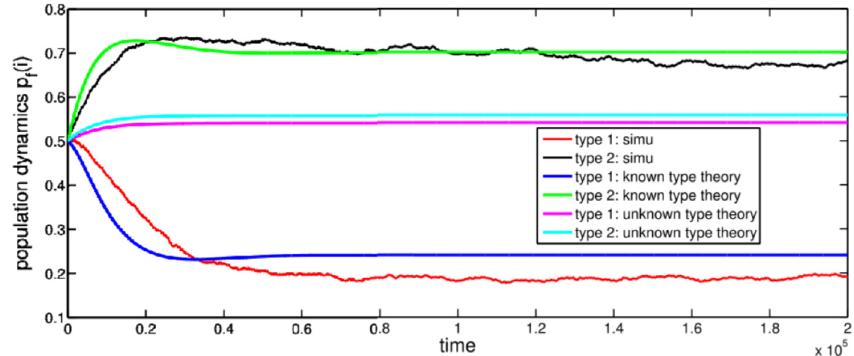
Figure 7. Simulation of evolutionary dynamics: the known user type model